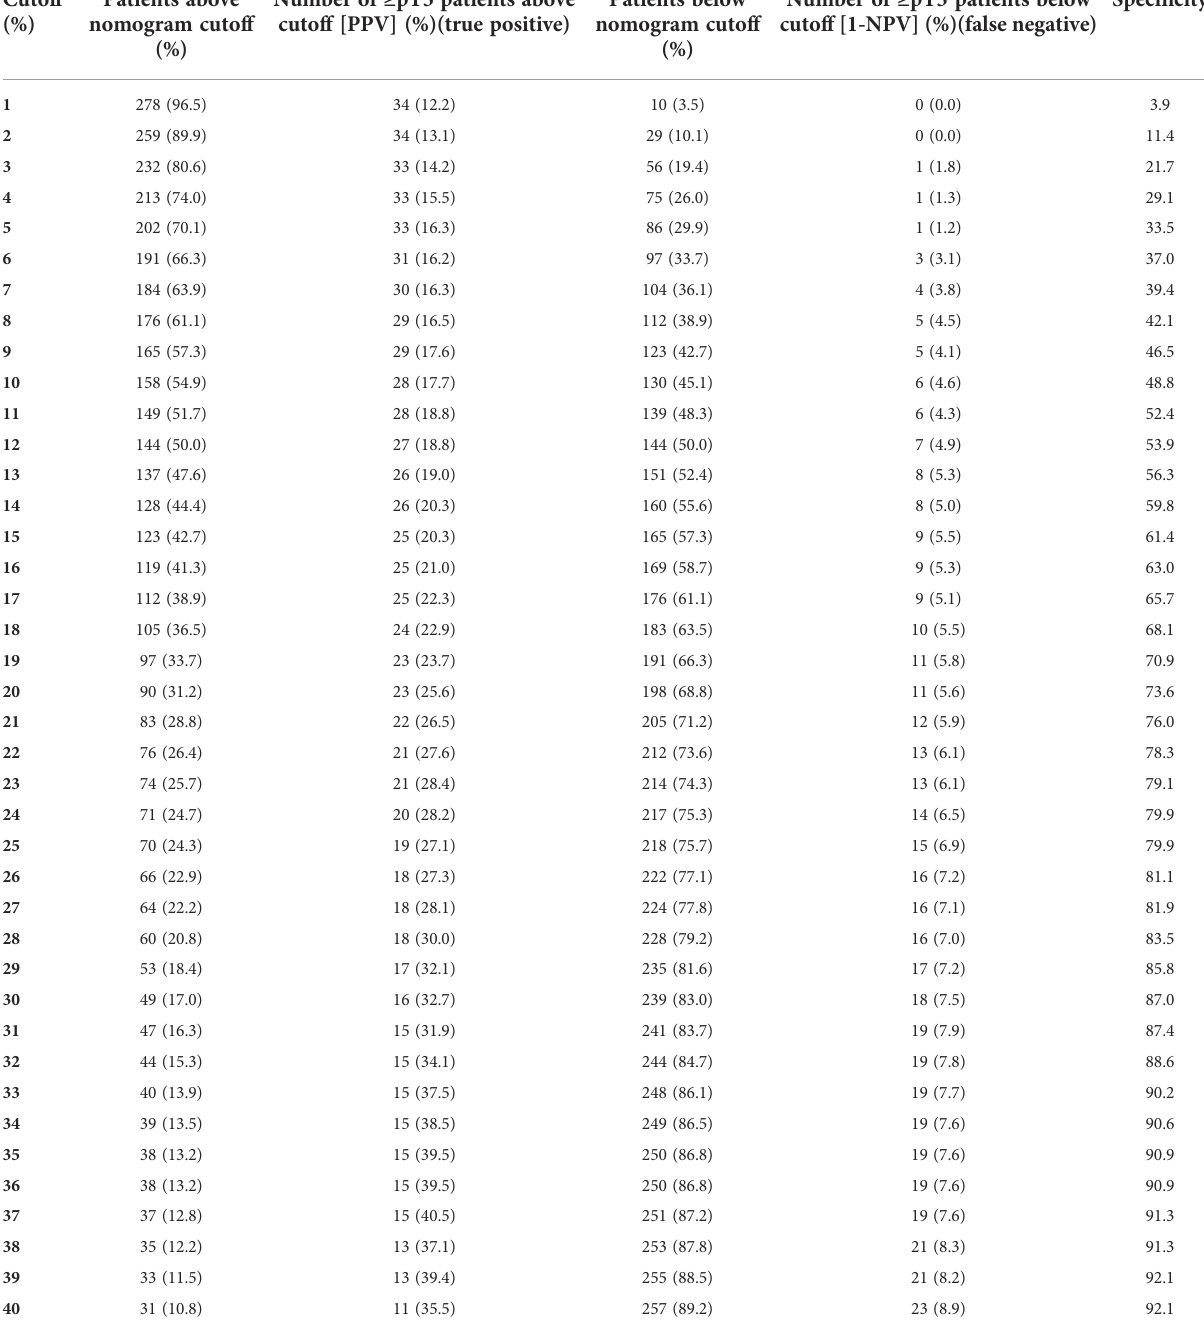
TABLE 3 Analyses of nomogram cutoffs in 288 cT1 clear cell-renal cell carcinoma